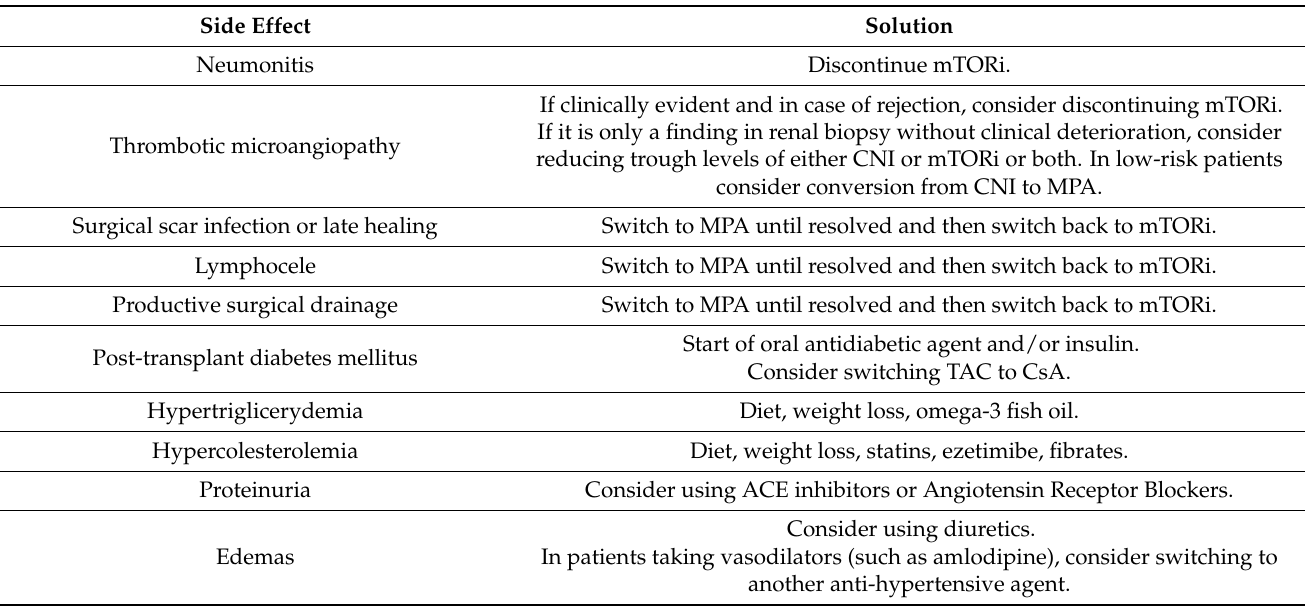
Table 1. Most common side effects of mTOR inhibitors in kidney transplantation with a list of possible